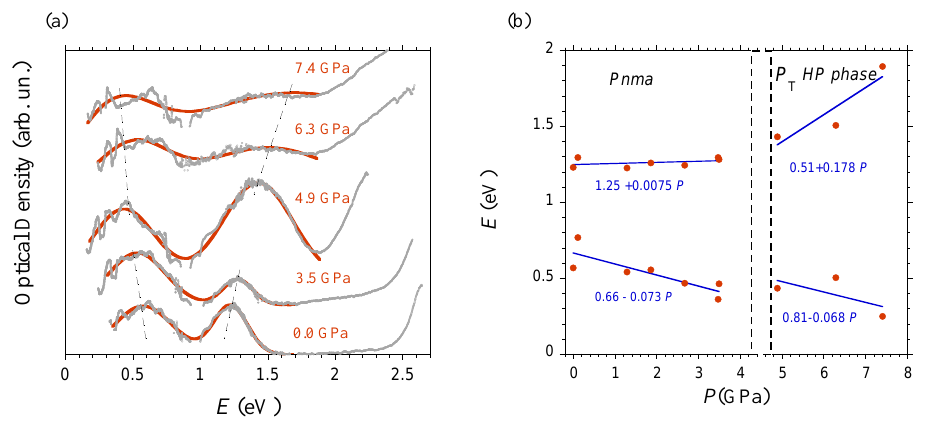
Figure 2: (a) Variation of the absorption spectrum of Cs 2 CuCl 4 with pressure in the Pnma and high-pressure phase ( P > 4.9 GPa). (b) Variation of the peak energy of the main absorption bands with pressure. Pressure coefficients dereived by fitting in the low-pressure Pnma phase are included.